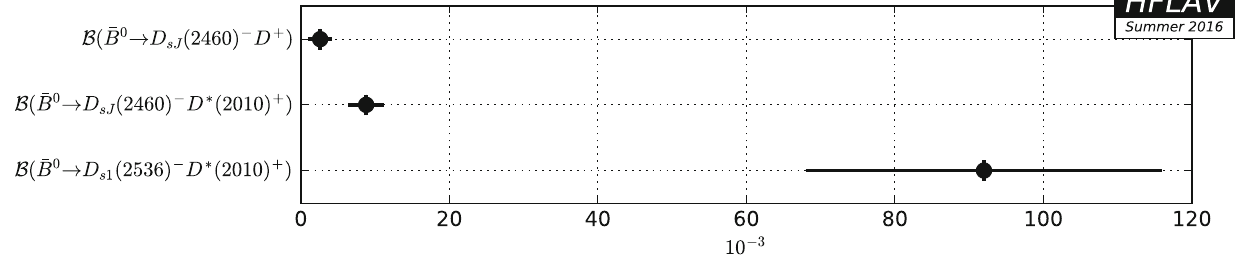
Fig. 87 Summary of the averages from Table 113